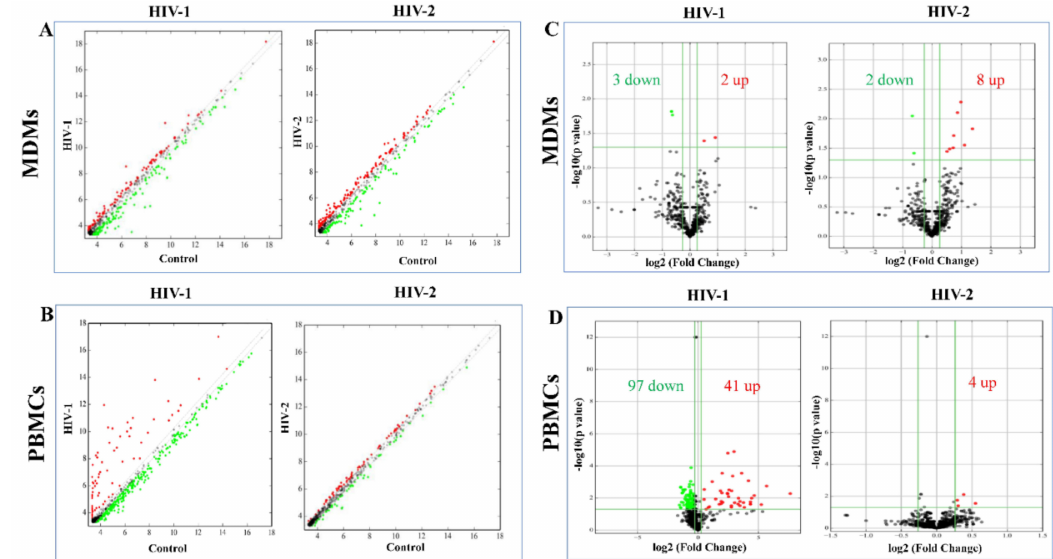
Figure 3. Scatter plots and volcano plots to identify di ff erentially expressed miRNAs in MDMs and PBMCs. Scatter plots used to identify di ff erentially expressed miRNAs in ( A ) HIV-1 / HIV-2-infected MDMs versus uninfected control MDMs. ( B ) HIV- / HIV-2-infected PBMCs versus uninfected control PBMCs. The axis represents the mean normalized miRNA signal values for each comparator group (log2 scaled). The gray fold change lines represent 1.2 × fold change. Red dots represent miRNAs that are upregulated ( > 1.2 fold) and green dots represents miRNAs that are downregulated ( < 1.2-fold). Volcano plots used to identify di ff erentially expressed miRNAs in ( C ) HIV-1 / HIV-2-infected MDMs versus uninfected control MDMs. ( D ) HIV- / HIV-2-infected PBMCs versus uninfected control PBMCs. The x -axis represents fold change values (log2 scale), while the y -axis represents p -values ( − log10 scale). The green vertical lines correspond to 1.2 × upregulation and downregulation, respectively, while the green horizontal line corresponds to a p -value of 0.05. The red dots represent di ff erentially upregulated miRNAs and green dots represent downregulated miRNAs of statistical